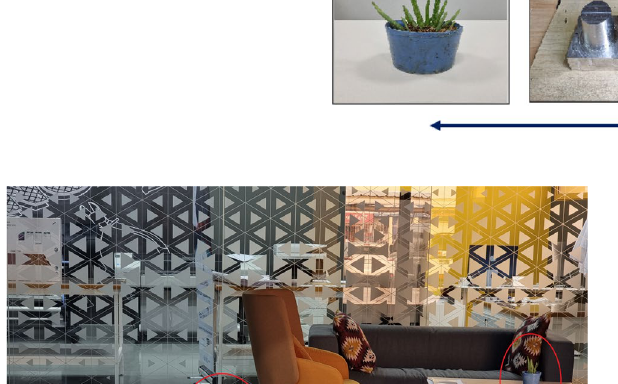
Fig. 23 Flow of the overall recycling system